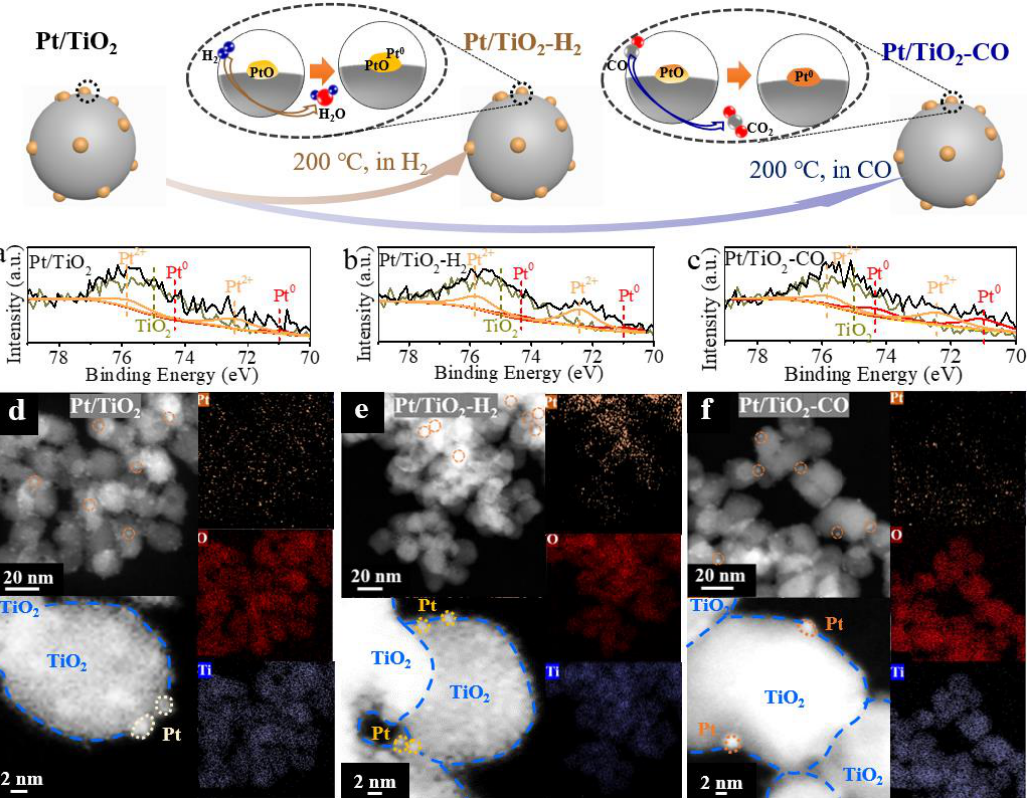
Figure 2. Up: Schematic diagram of the Pt/TiO 2 pretreated in H 2 and CO; Down: ( a – c ) XPS narrow spectra of Pt 4f for ( a ) Pt/TiO 2 , ( b ) Pt/TiO 2 -H 2 , and ( c ) Pt/TiO 2 -CO catalysts; and ( d – f ) high-resolution, high-angle annular dark-field (HAADF) STEM images, EDS-mapping and size distribution of ( d ) Pt/TiO 2 , ( e ) Pt/TiO 2 -H 2 , and ( f ) Pt/TiO 2 -CO catalysts.